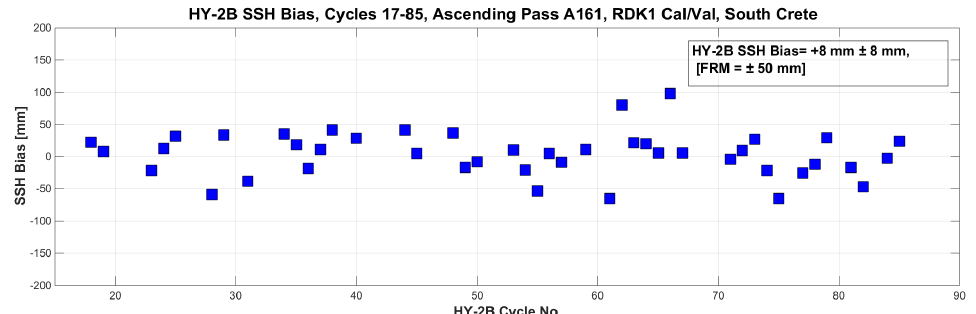
Figure 13. The HY-2B SSH bias as determined by the RDK1 Cal/Val site and the ascending pass A161, southwest of Crete. Cycles are from No. 17 (16 June 2019) to No. 86 (6 February 2022) and GDR Version 2.